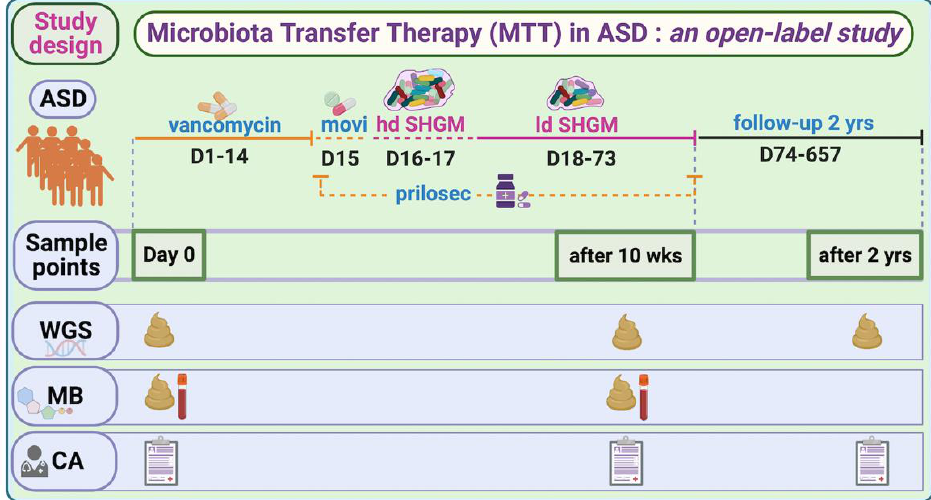
Figure 1. Overview of MTT trial in ASD and study time points for this work. hd — high dose; ld — low dose; SHGM — standardized human gut microbiota; WGS — whole-genome sequencing; MB — metabolomics; CA — clinical assessment (includes all ASD- and GI-associated symptoms; movi — MoviPrep. For complete trial information, refer to [7,11,20].